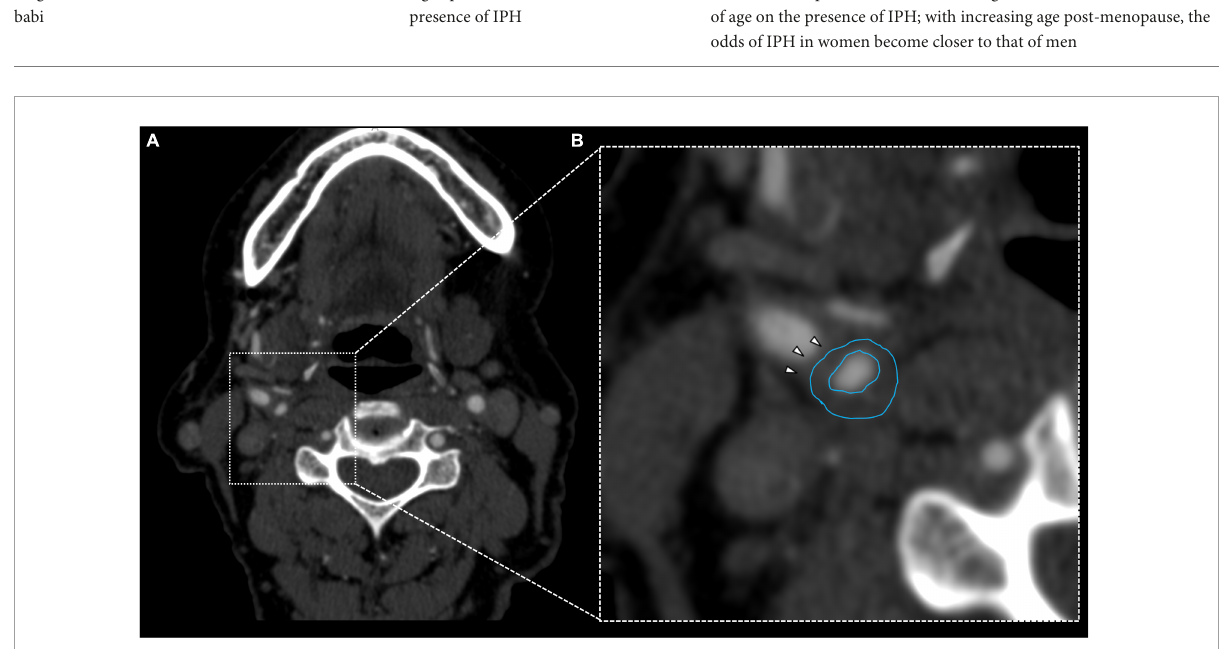
FIGURE3 Fifty-six years old female showing fibrofatty plaque with concentric remodeling on right ICA (A) . Plaque analysis confirmed the fatty composition of the plaque ( B , white arrowheads).